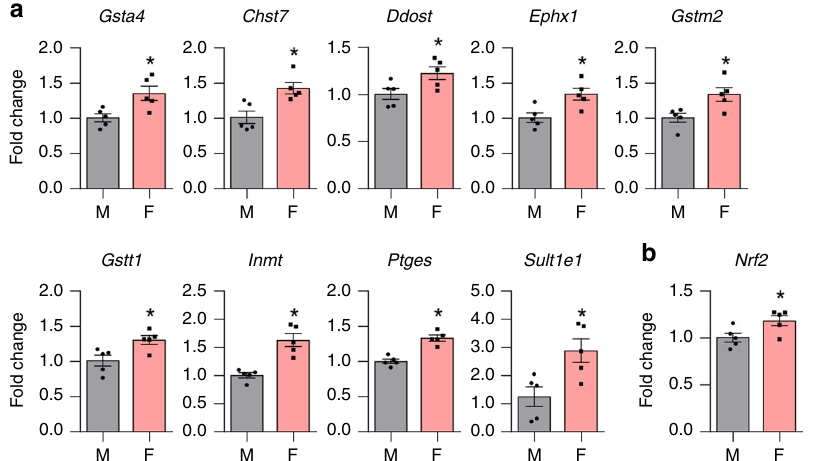
Fig. 6 Assessment of mRNA expression levels of detoxi fi cation genes in the inner ears of CBA/CaJ mice. a mRNA expression levels of nine genes involved in the enzymatic processes of Phase II detoxi fi cation were analyzed by PCR arrays in the inner ears from male and female CBA/CaJ mice. n = 5, * p < 0.05 vs. M (unpaired two-tailed Student t test). Error bars represent ± s.e.m. b mRNA expression levels of Nrf2 were measured by qRT-PCR in the inner ears from male and female CBA/CaJ mice. n = 5, * p < 0.05 vs. M (unpaired two-tailed Student t test). Error bars represent ± s.e.m. The relative mRNA levels were normalized to levels of B2m . M: male, F: female. Source data are provided as a Source Data fi